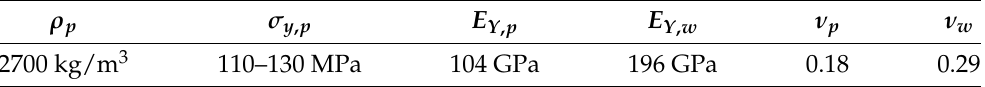
Table 1. Mechanical properties of the Arizona Road Dust particle and wall